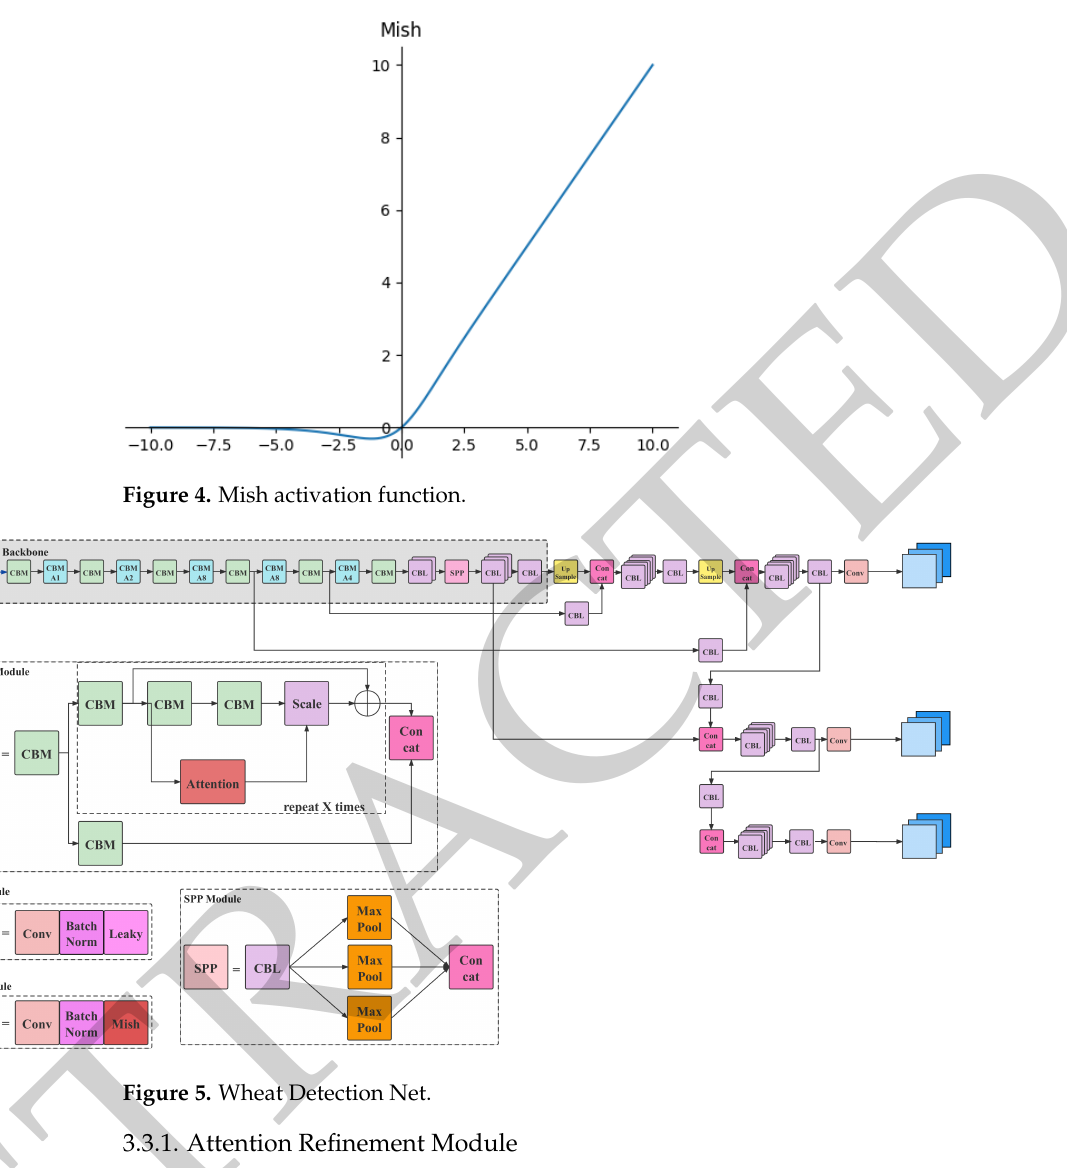
Figure 5. Wheat Detection